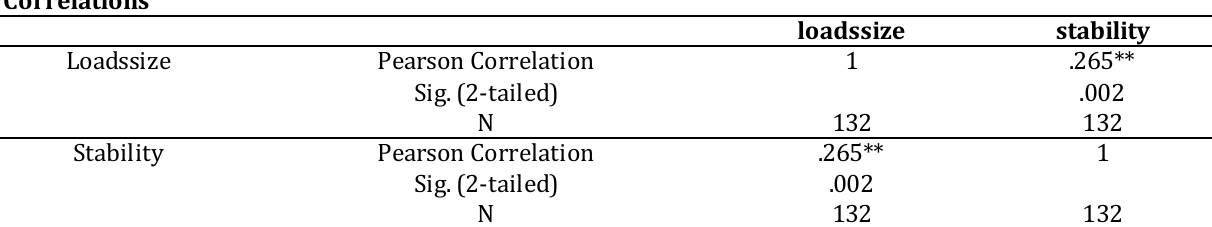
loadssize stability